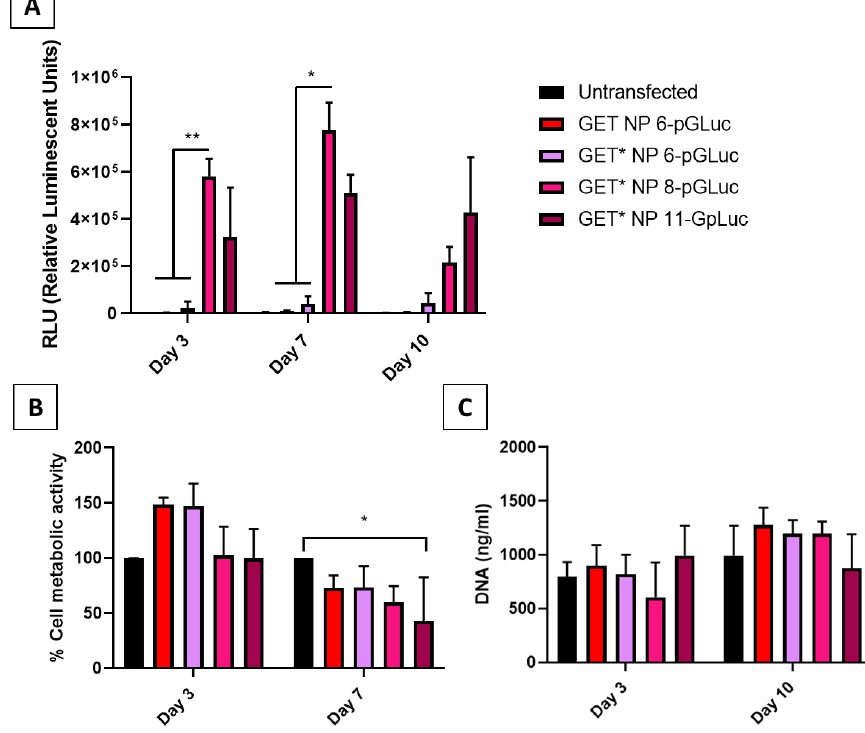
Figure 3. ( A ) The highest transfection efficiency was attained using GET* N/P 8 nanoparticles at both day 3 and day 7 post-transfection. ( B ) GET* nanoparticles did not have any adverse effect on cell metabolic activity (%) at day 3 but was significantly reduced in GET* N/P 11 transfected cells at day 7 post-transfection, compared with untransfected controls. ( C ) There were no significant differences in cell proliferation compared with untransfected controls, measured by DNA content at any timepoint. Error bars represent ±SD, n = 3 tested in triplicate, significance ( p < 0.05 *, p < 0.01 **).